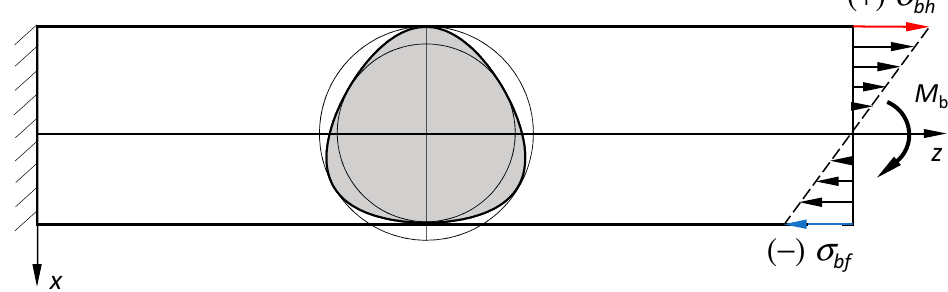
Figure 5. The bending coordinate system for a loaded profile shaft.